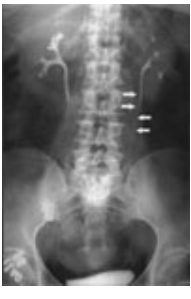
FIGURE 2. IVP showing the filling defects in the left ureter of first patient.